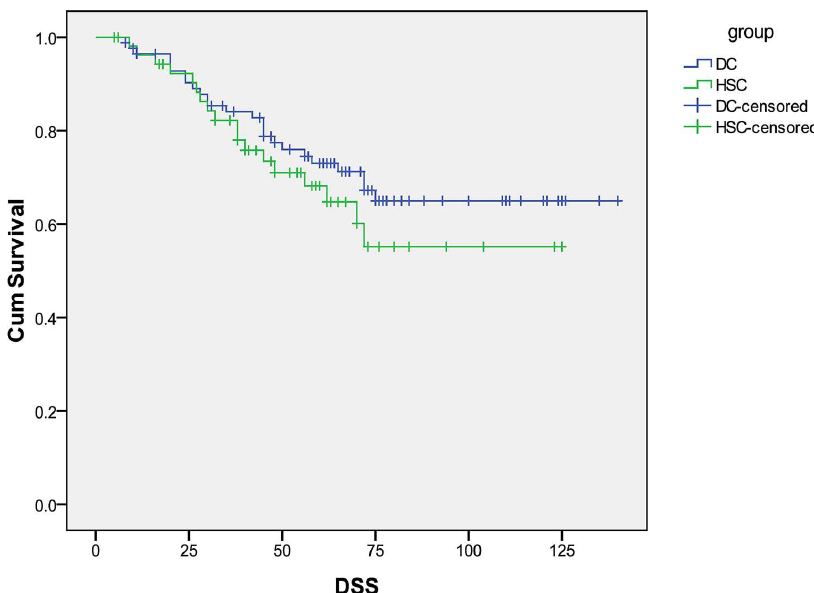
Fig 1. Disease-specific survival in patients with type II endometrial cancer diagnosed with hysteroscopy (HSC) versus D&C. rate of positive peritoneal cytology in patients with type II EC (30 versus 12%, p = 0.008),